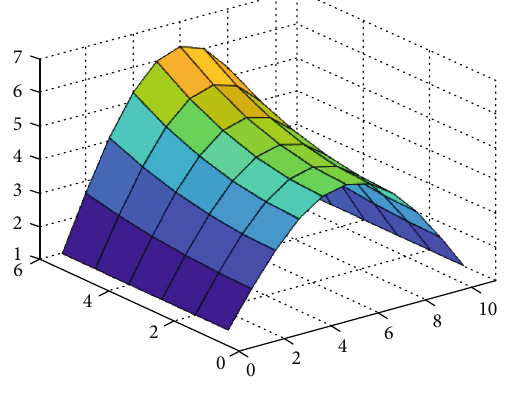
Figure 3: p = 1 , k = 1 .